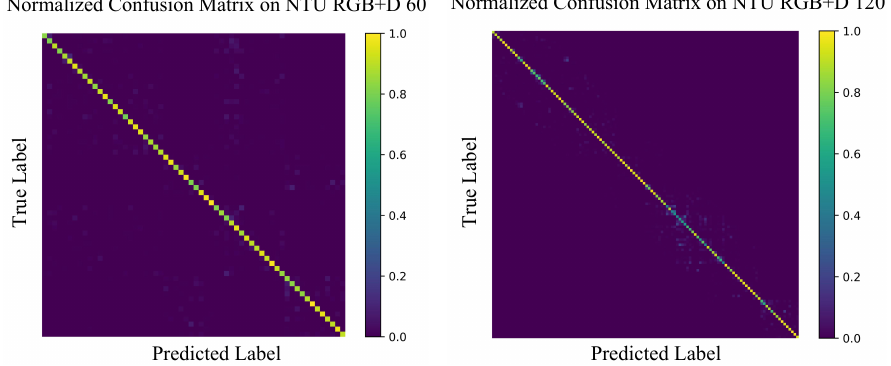
Figure 8. The normalized confusion matrix of the skeleton stream on NTU RGB+D 60 ( left ) and NTU RGB+D 120 ( right ).